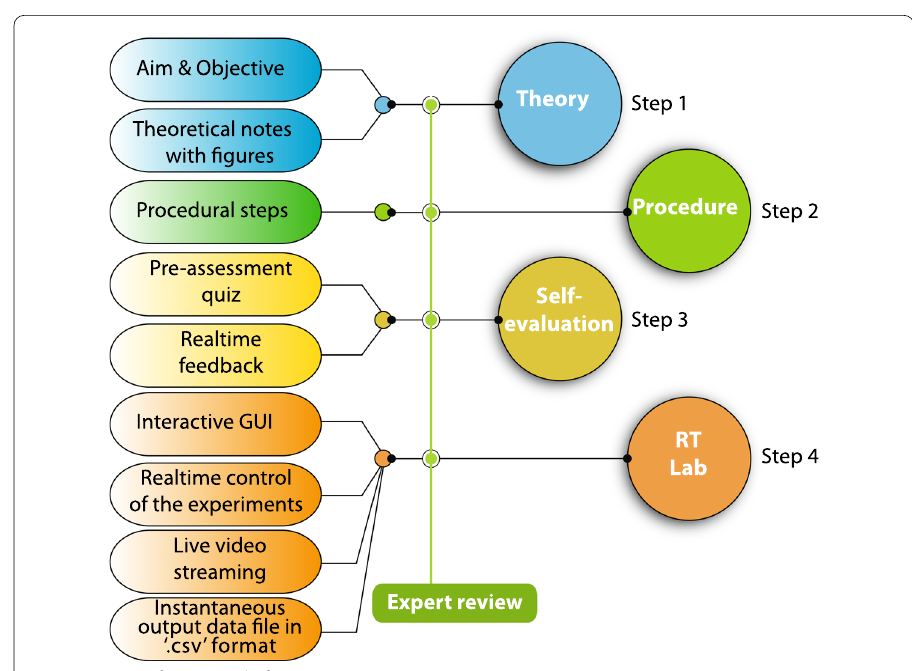
Fig. 3 Design of RT-UTM